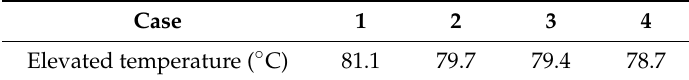
Figure 5. Results of the thermal distribution analysis as a function of the thickness of tunnel-type bus-bar. Table 3. Elevated temperatures as a function of tunnel-type bus-bar thickness calculated from thermal analysis.